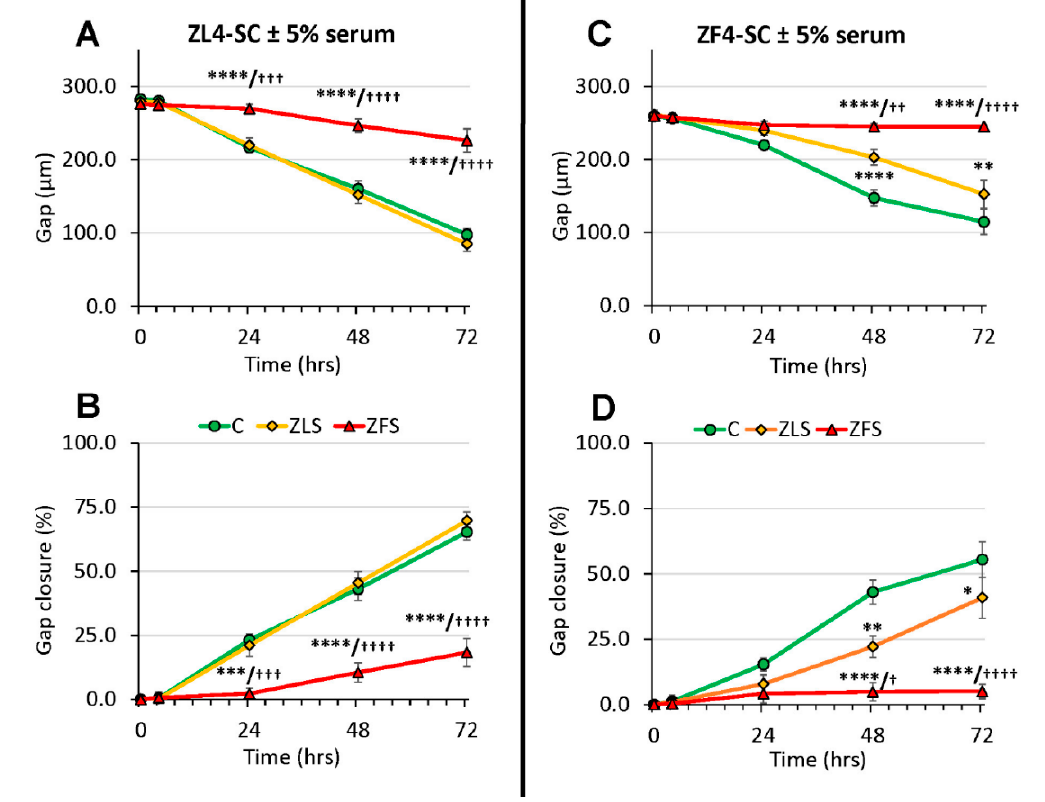
Figure 6. The efficacy of gap closure by ZF4-SC after gap injury was lower than the one for ED-MDSC, and it was more damaged by ZFS, but ZL4-SC were less affected than ZF4-SC . Experiments and measures were as in Figure 5, but with the female stem cells, and the female abbreviations. Panels ( A ) and ( C ): ZL4-SC; Panels ( B ) and ( D ): ZF4-SC; **** p ≤ 0.0001 (C vs. ZFS), *** p ≤ 0.005 (C vs. ZLS), ** p ≤ 0.01 (C vs. ZLS), and + p ≤ 0.05 (ZLS vs. ZFS), +++ p ≤ 0.005 (ZLS vs. ZFS), and ++++ p ≤ 0.0001 (ZLS vs. ZFS).